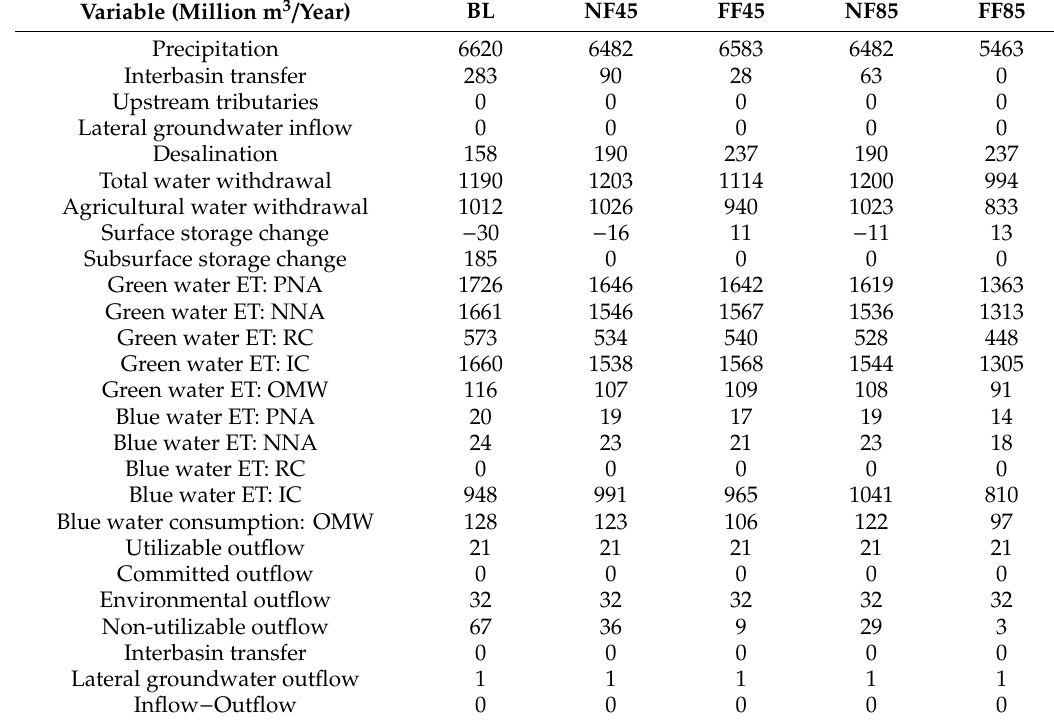
Table A2. Resource base sheet for the Segura river basin, Spain.